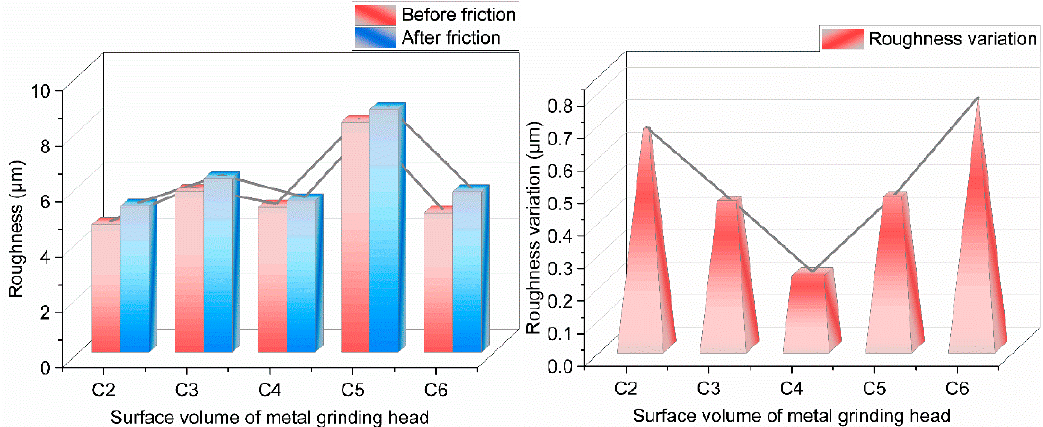
Figure 15. Metal surface roughness.